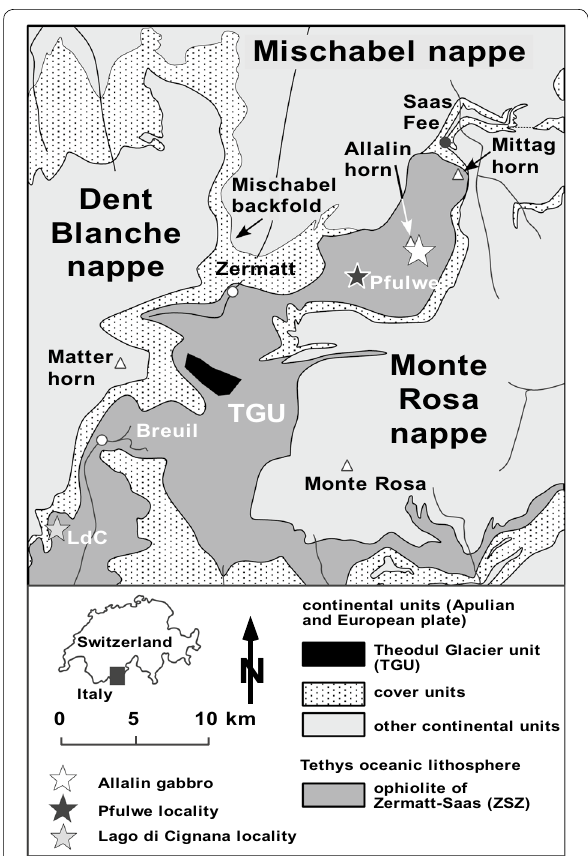
Fig. 1 Simplified tectonic map of the Zermatt-Saas ophiolite zone (modified after Bearth 1967). The Mischabel and Monte Rosa nappe are Penninic crystalline basement (European plate), the Dent Blanche nappe represents Austroalpine continental basement (Apulian plate). TGU Theodul Glacier Unit (Weber and Bucher 2015) see detailed geological map Fig. 3, LdC Lago di Cignana coesite locality (Reinecke 1991, 1998), eclogitic pillow lavas at Pfulwe locality (Bucher et al. 2005), eclogite facies meta-gabbro at Allalinhorn (Bucher and Grapes